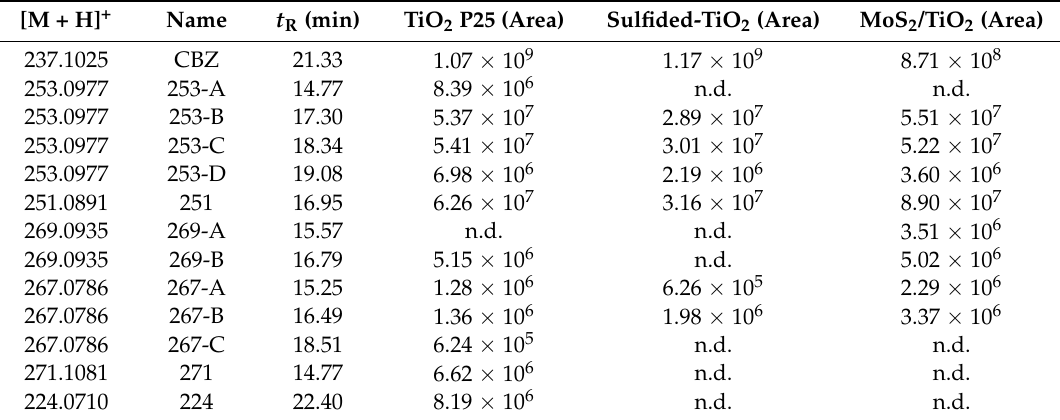
Table 1. CBZ and transformation products (TPs) identified during the photocatalytic experiments with the three materials (area detected after 15 min of